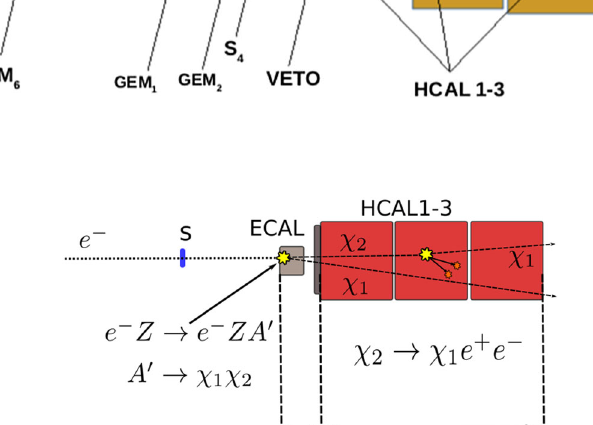
Fig. 3 A schematic view of an event A (cid:2) → χ 1 χ 2 (χ 2 → χ 1 e + e − ) from a A (cid:2) produced after a 100 GeV e − scatters off in the active dump, e − Z → e − Z A (cid:2) . The χ 2 particle decaying within HCAL2 corresponds to the S1 signature (see text for more details)